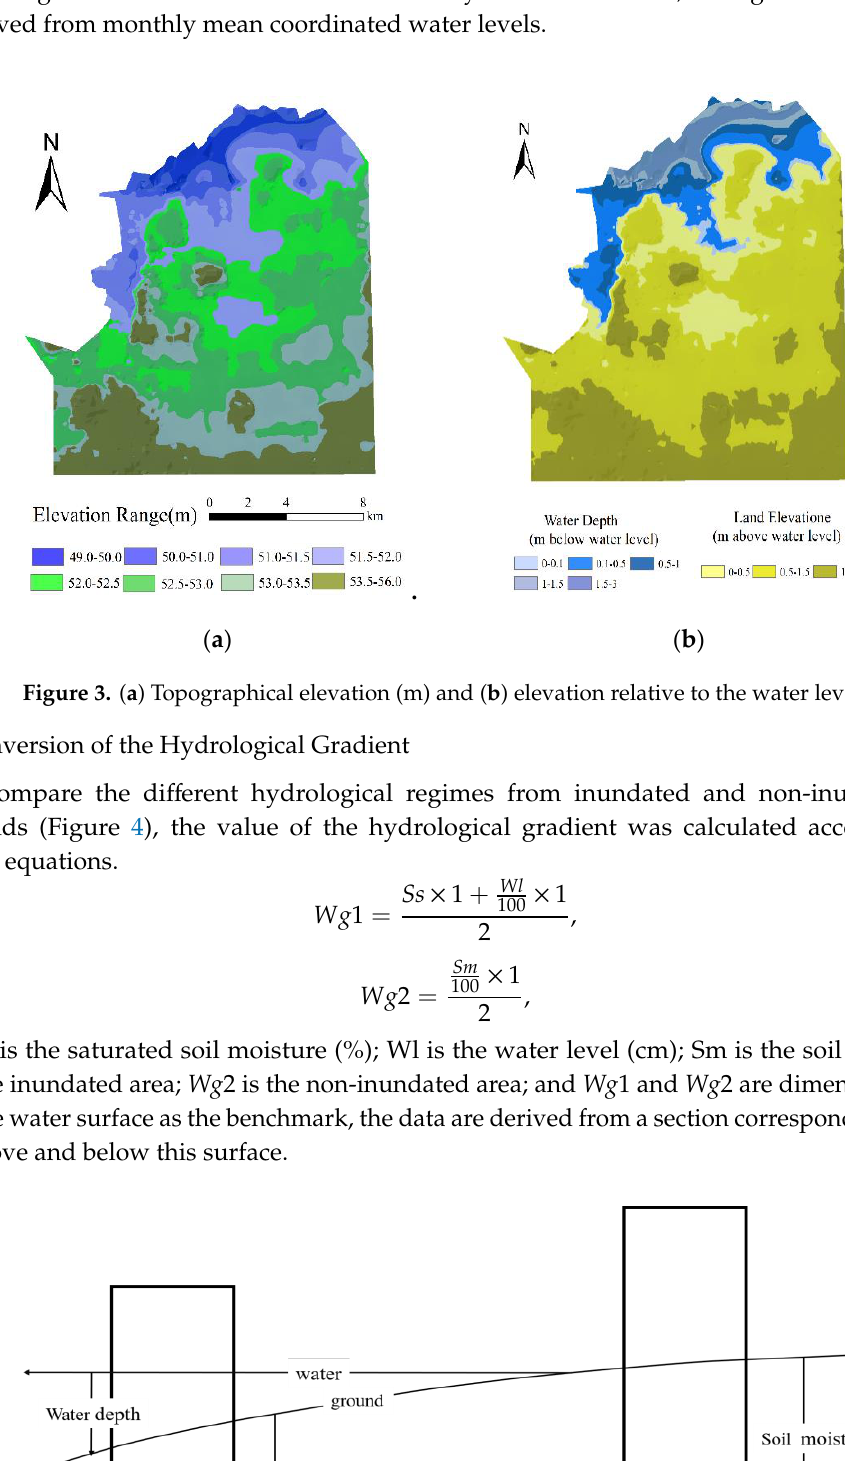
Figure 4. Conversion of the hydrological gradient.